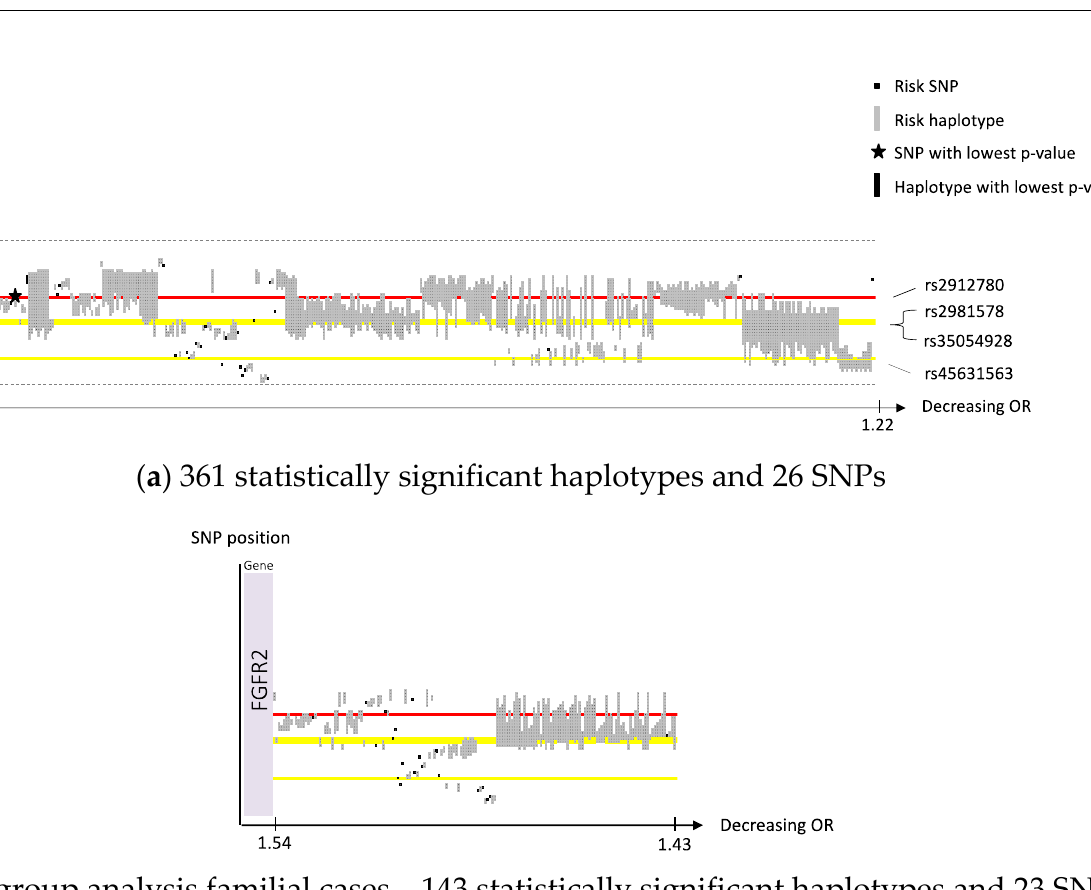
Figure 1. Chromosome 10, haplotypes and SNPs sorted on OR. ( a ) SNP position on the y -axis. Gene position for FGFR2 is indicated along the y -axis. Corresponding OR on the x -axis. The red line indicates the position of the SNP with the lowest p -value. The three yellow lines indicate the position of three previous published BCAC SNPs within the area. The dashed lines indicate the position of the proximal and distal SNP of the haplotype of window 50 with the lowest p -value (non-significant); ( b ) axis, red and yellow lines illustrated as in ( a ). Table 2. Published SNPs within the three loci on Chromosome 10, 11 and 16 in comparison with our data.